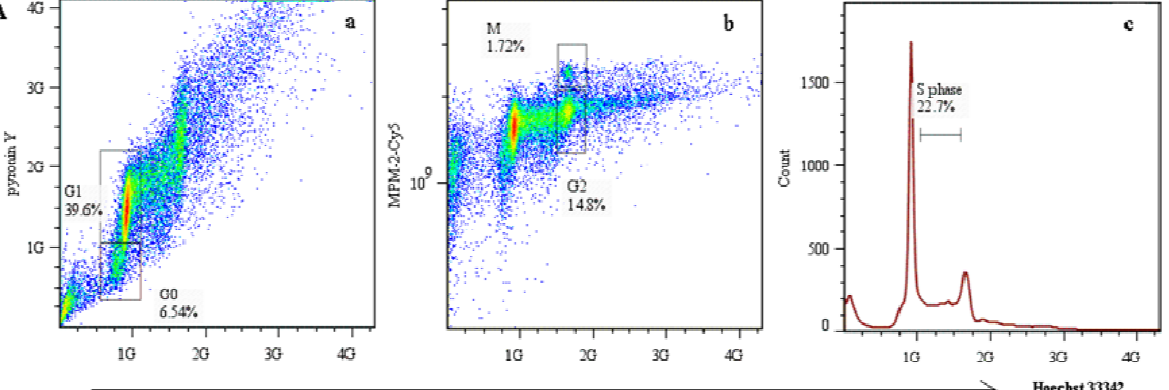
Figure 4. Accurate cell cycle distibution of crizotinib and taxol analyzed by the multiparameter method. ( A ) The bivariate distribution of DNA content (Hoechst 33342), RNA content (pyronin Y) and mitotic phosphoproteins (MPM-2-Cy5) in untreated Jurkat cell. ( a ) The bivariate dot plots showing DNA content and RNA content; ( b ) The bivariate dot plots showing DNA content and mitotic phosphoproteins; ( c ) DNA content histogram of Jurkat cell line, stained by Hoechst 33342. ( B ) The bivariate distribution of DNA content (Hoechst 33342), RNA content (pyronin Y) and mitotic phosphoproteins (MPM-2-Cy5) in crizotinib treated Jurkat cell. ( a ) The bivariate dot plots showing DNA content and RNA content; ( b ) The bivariate dot plots showing DNA content and mitotic phosphoproteins; ( c ) DNA content histogram of Jurkat cell line, stained by Hoechst 33342. ( C ) The bivariate distribution of DNA content (Hoechst 33342), RNA content (pyronin Y) and mitotic phosphoproteins in taxol treated Jurkat cell. ( a ) The bivariate dot plots showing DNA content and RNA content; ( b ) The bivariate dot plots showing DNA content and mitotic phosphoproteins content; ( c ) DNA content histogram of Jurkat cell line, stained by Hoechst 33342. ( D ) Histogram of the cell cycle distribution in the control cells and cells treated with crizotinib. ( E ) Histogram of the cell cycle distribution in the control cells and cells treated with taxol. Values represent the means ± SD. * p values less than 0.05 were considered statistically significant and p values less than 0.01 were considered extremely striking. Data were obtained in three independent experiments and the representative results were